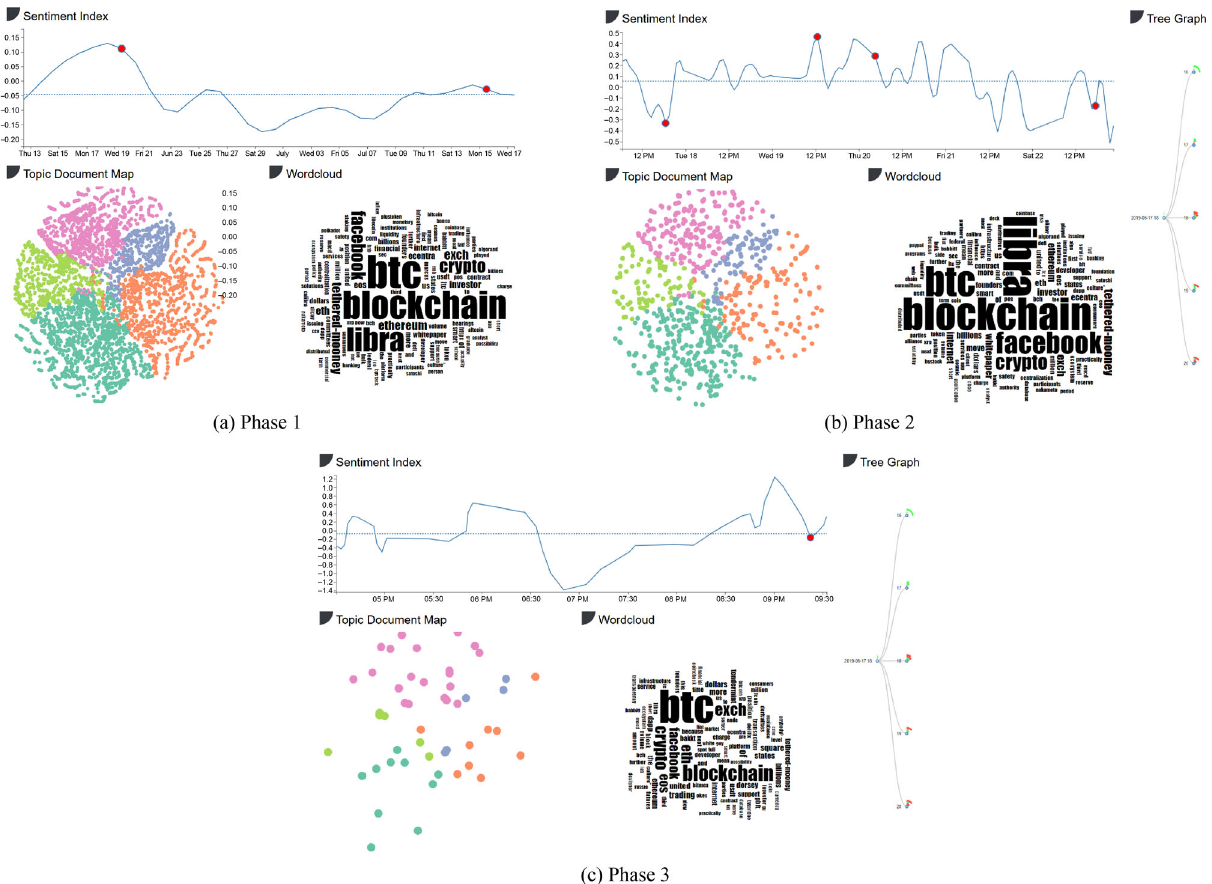
Fig. 9 Libra case: sentiment score, topic document map, and wordcloud in the three